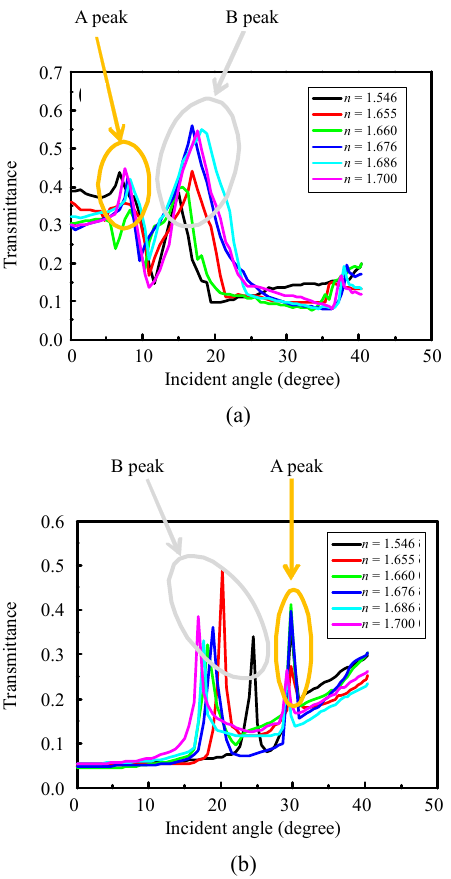
Fig. 6 Experimental results for the transmittance as a function of the incidence angle between 0 ° and 50 ° for a varying refractive index: (a) period of 500 nm and (b) period of 300